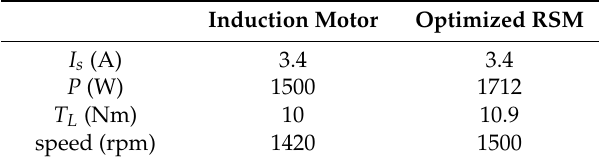
Table 2. Comparison of original, new designed RSM rotor and induction motor measured